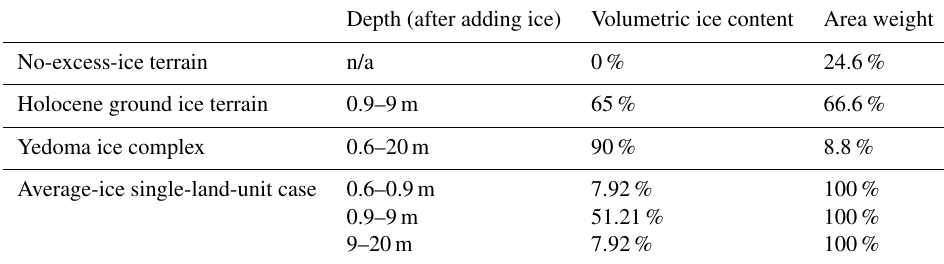
Table 1. The excess-ice initialization scenario in each of the three terraces (land units) for the Lena River delta, as well as that for the single-land-unit excess-ice initialization